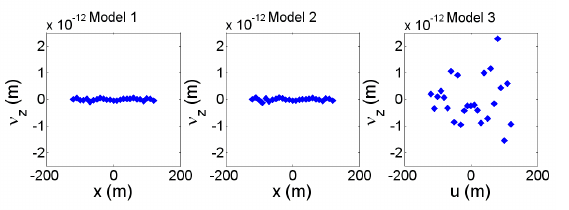
Figure 8. z-residuals from the 3D catenary model least squares fitting with the simulated data.